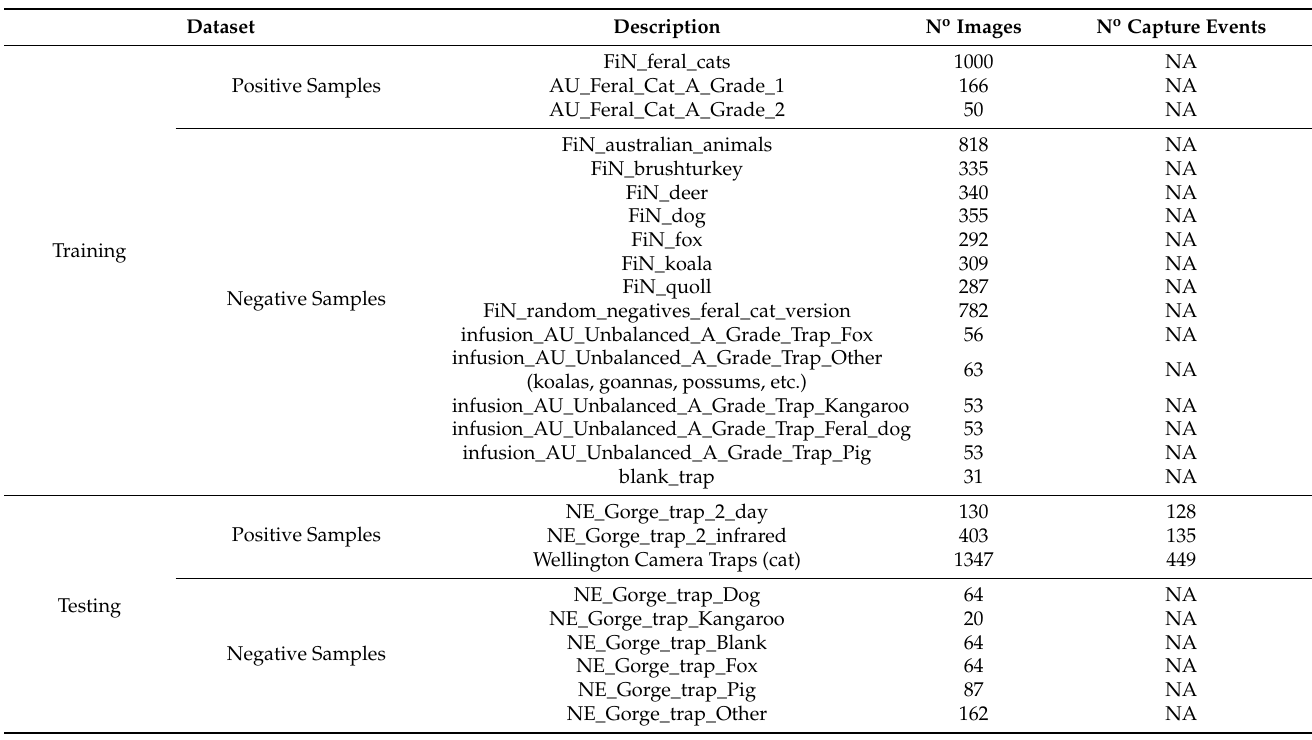
Table 2. FiN stands for FlickR and iNaturalist images. Images were downloaded and pre-processed using the procedure described by